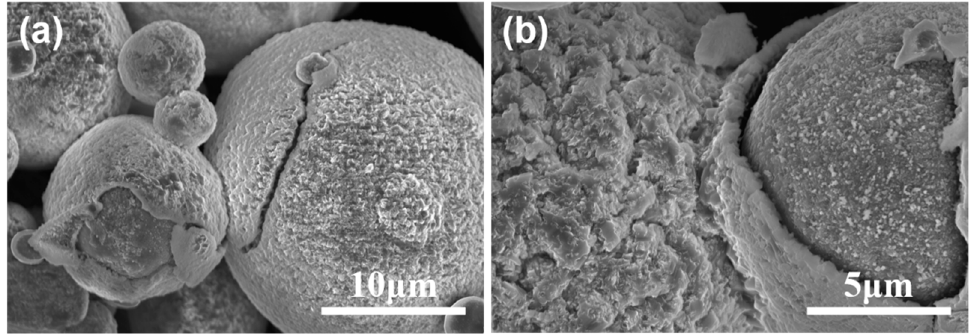
Figure 9. ( a ) SEM morphology of connected powder in HAZ, ( b ) SEM morphology of a neck formation of two powder via solid-phase sintering.